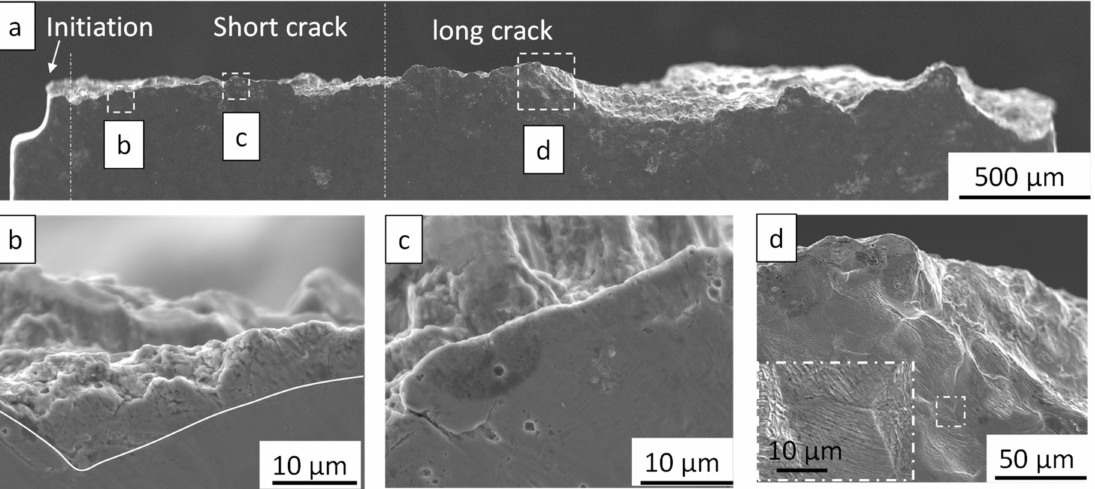
Figure 8. Wide view of the outer surface of the specimen after the occurrence of the final fracture ( a ) and three enlargements in the short cracking ( b , c ) show little plasticity, and the long cracking ( d ) presents much